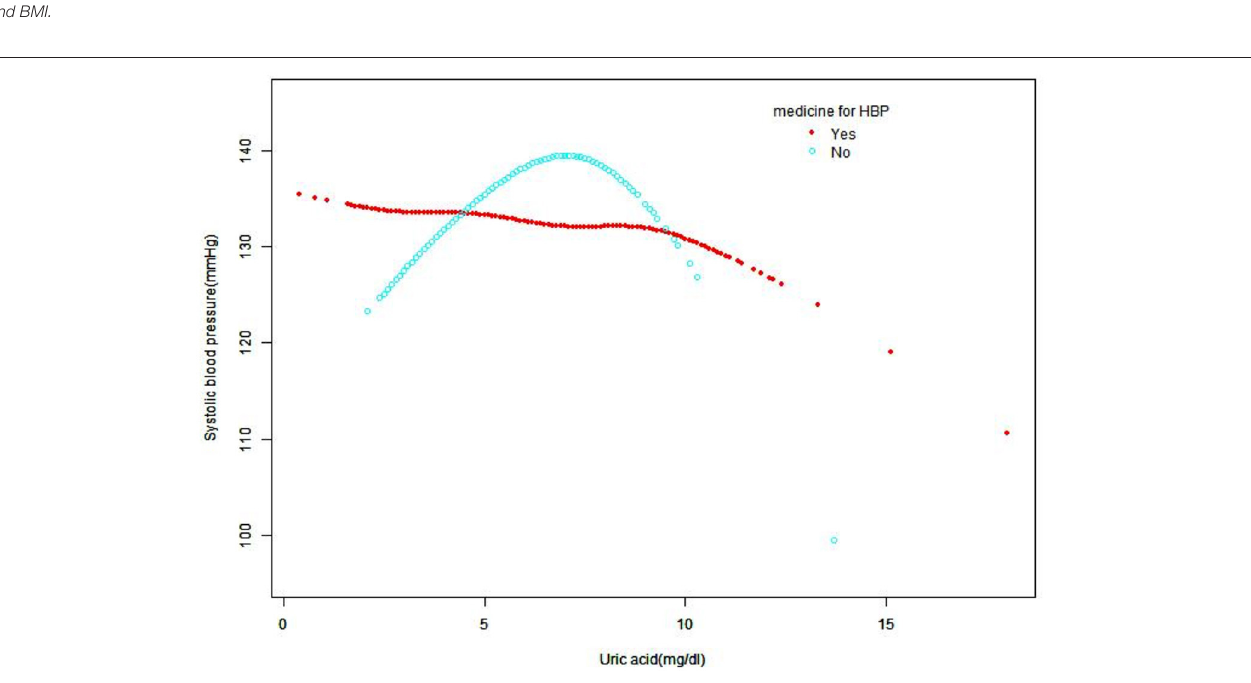
FIGURE 2 | Smooth curve fitting for the relationship between UA and SBP in hypertension treatment group and non-treatment group, adjusted for gender, age, race, creatinine, glucose, hemoglobin, HDL, TC, GFR, LDL, alcohol consumption, diabetes, smoking, and BMI. HDL, high-density lipoprotein; TC, total cholesterol; GFR, glomerular filtration rate; SBP, systolic blood pressure; UA, uric acid; LDL, low-density lipoprotein; BMI, body mass index; HBP, high blood